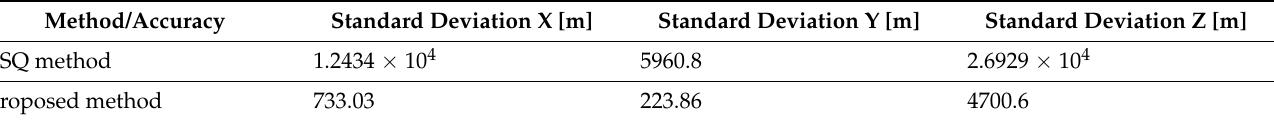
Table 6. Comparison the results of both the LSQ and median filter